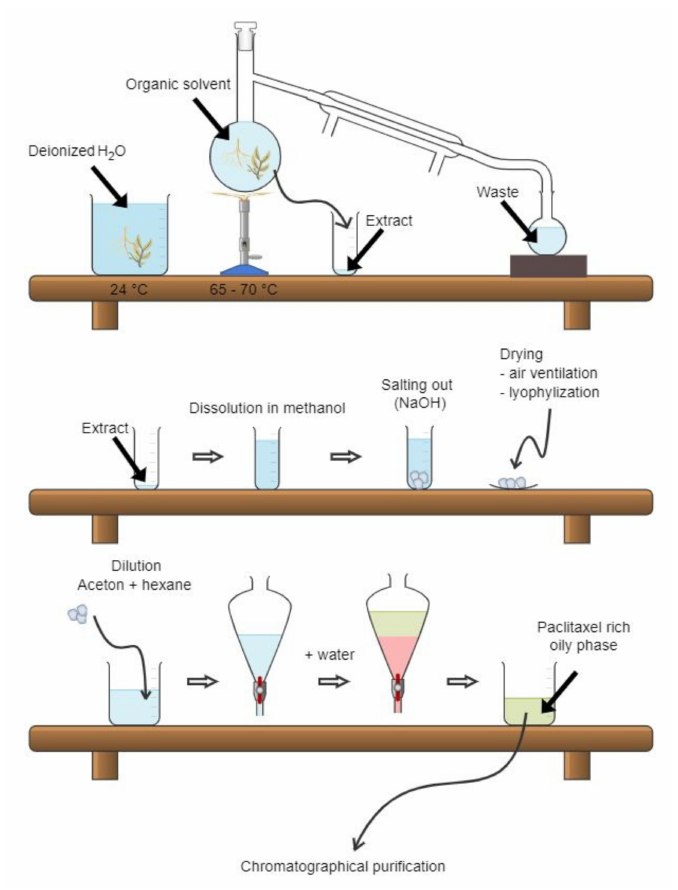
Figure 4. Scheme of basic paclitaxel isolation, created with Chemix